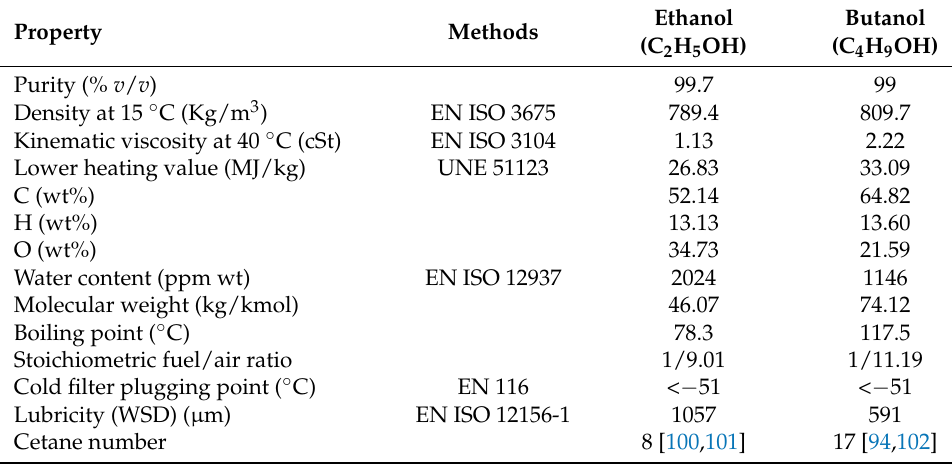
Figure 5. Bibliometric diagram ISI web of knowledge [97]. Table 2. Summary of ethanol and n-butanol properties